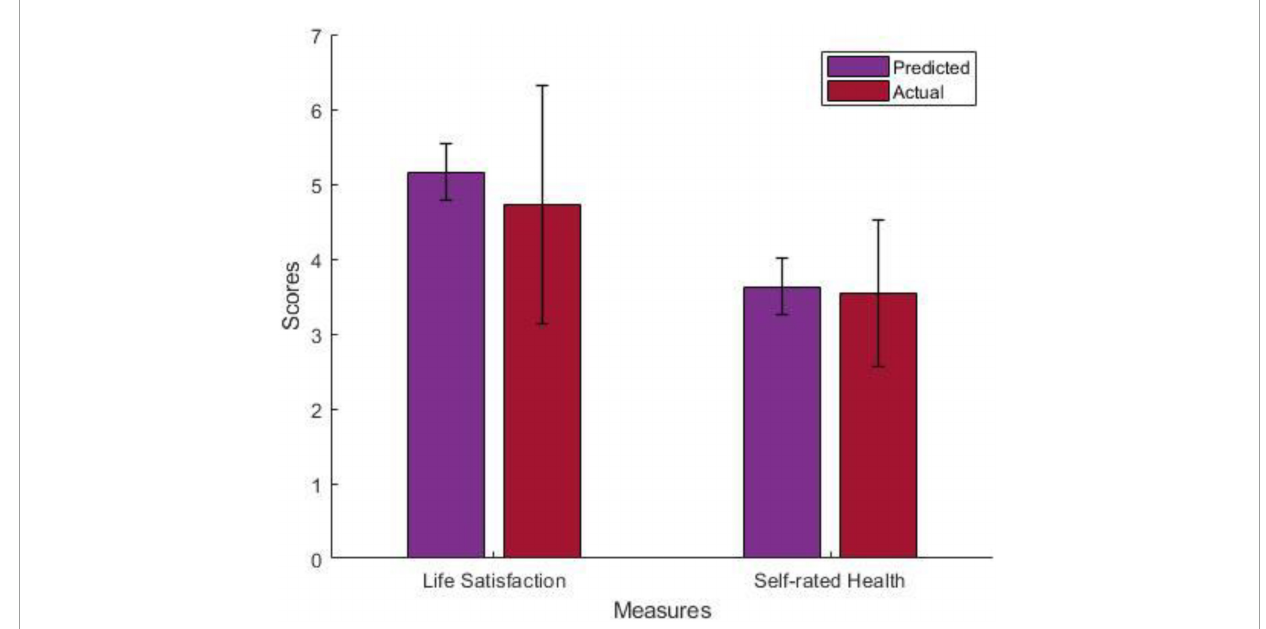
FIGURE1 The mean and standard deviation of predicted and actual life satisfaction and SRH scores for people who used illegal drugs the past year.